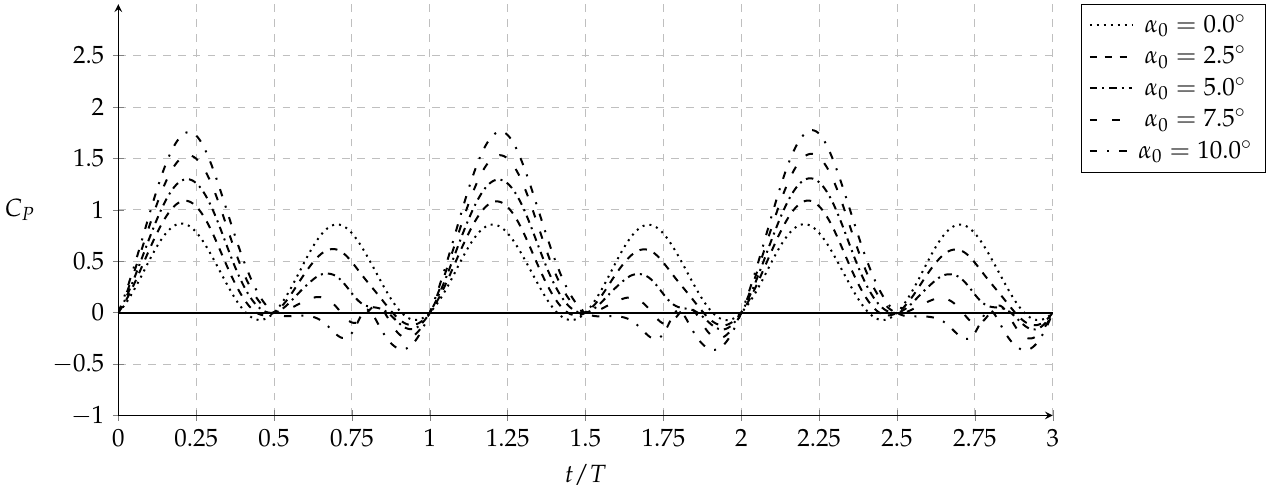
Figure 19. Power coefficient as a function of t / T and α 0